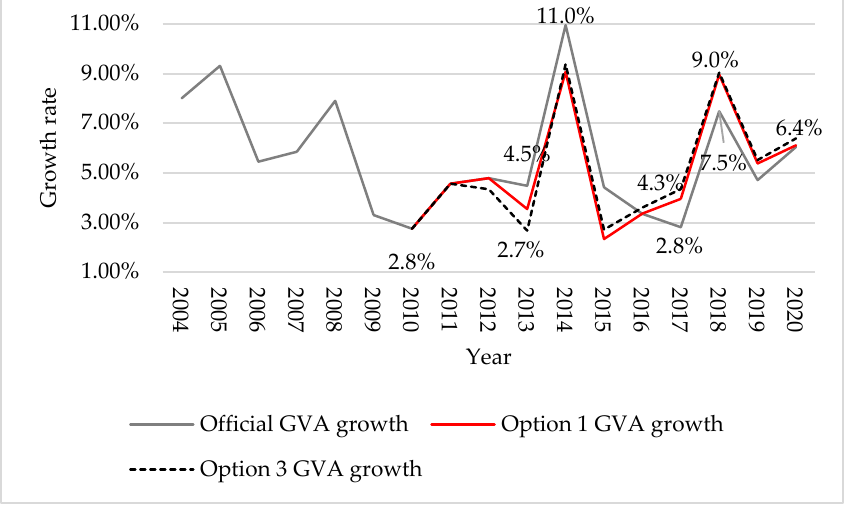
Figure 8. Canterbury economic growth, 2004–2020. Source : (MBIE 2021) and author’s calculations.